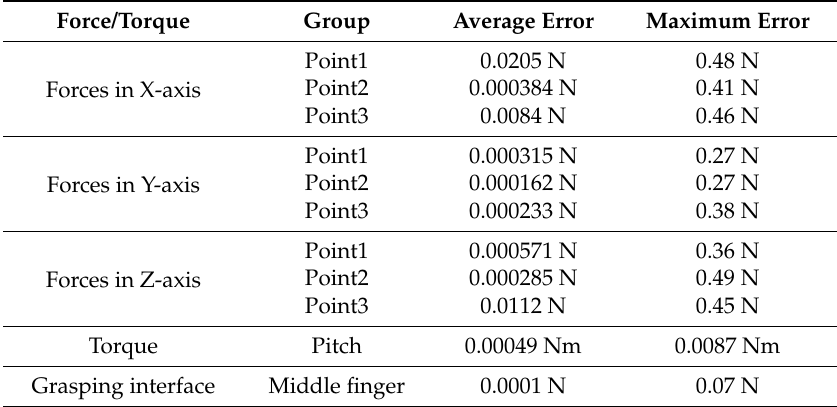
Table 1. Errors of Table 1. Errors of Force/Torque.